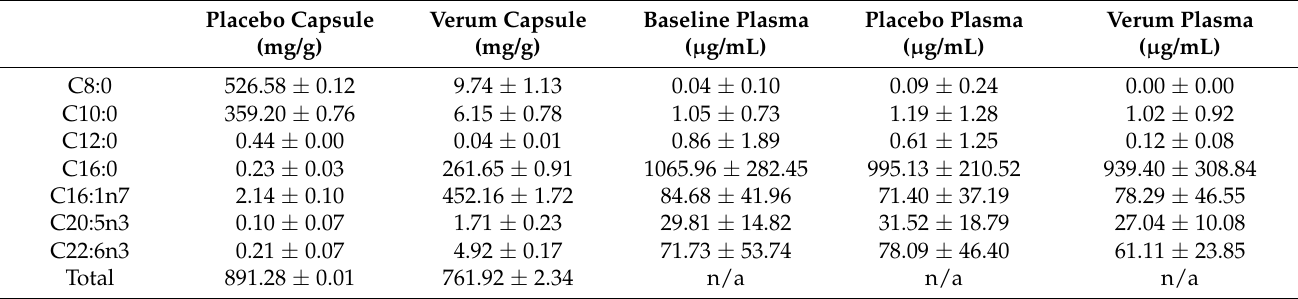
Table 3. Analysis of Fatty Acids in Placebo Capsules, Verum Capsules and